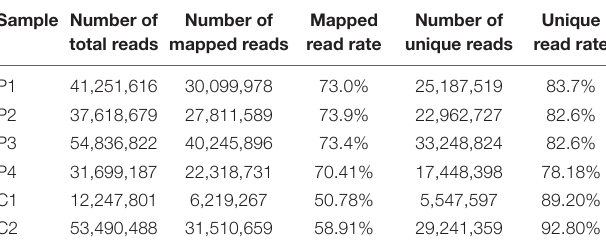
TABLE 2 | Statistics summary of MeDIP-seq